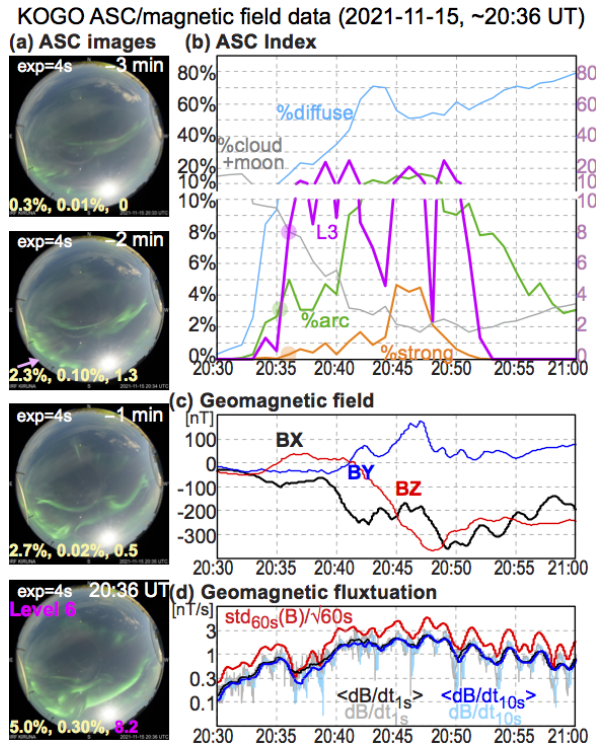
Figure 10. The same as Fig. 8 for the Level 6 auroral activity at 20:36UT on 15 November 2021.